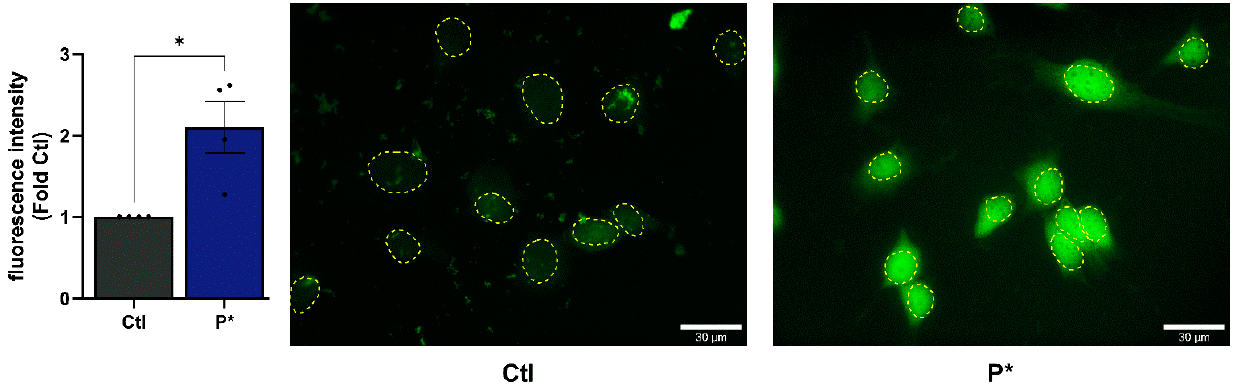
Figure 2. Intracellular H 2 S release by P*. ATDC5 cells were incubated for 30 min with the H 2 S fluorescent probe WSP-5 followed by incubation with 1 mM P* for 30 min. Approximate nuclear outlines (yellow) were traced from the corresponding bright-field images, which are presented in Supplementary Figure S2. Scale bar = 30 µm. Results are expressed as relative quantity compared to untreated cells (Ctl) set to 1, n = 4, * p < 0.05 (unpaired t -test).